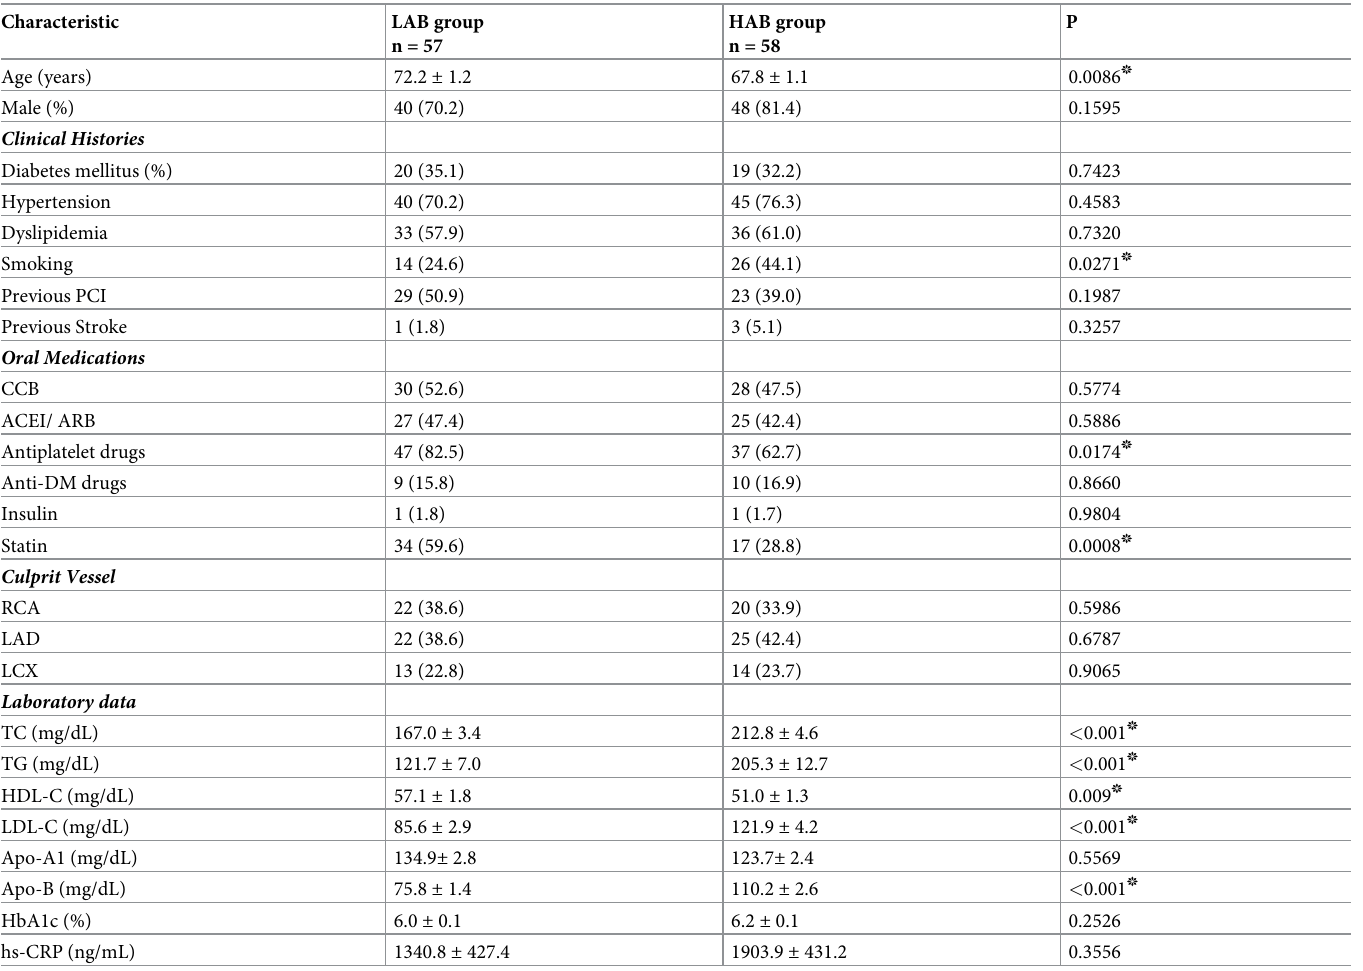
Table 1. Characteristics and laboratory data in patients with low and high plasma apolipoprotein